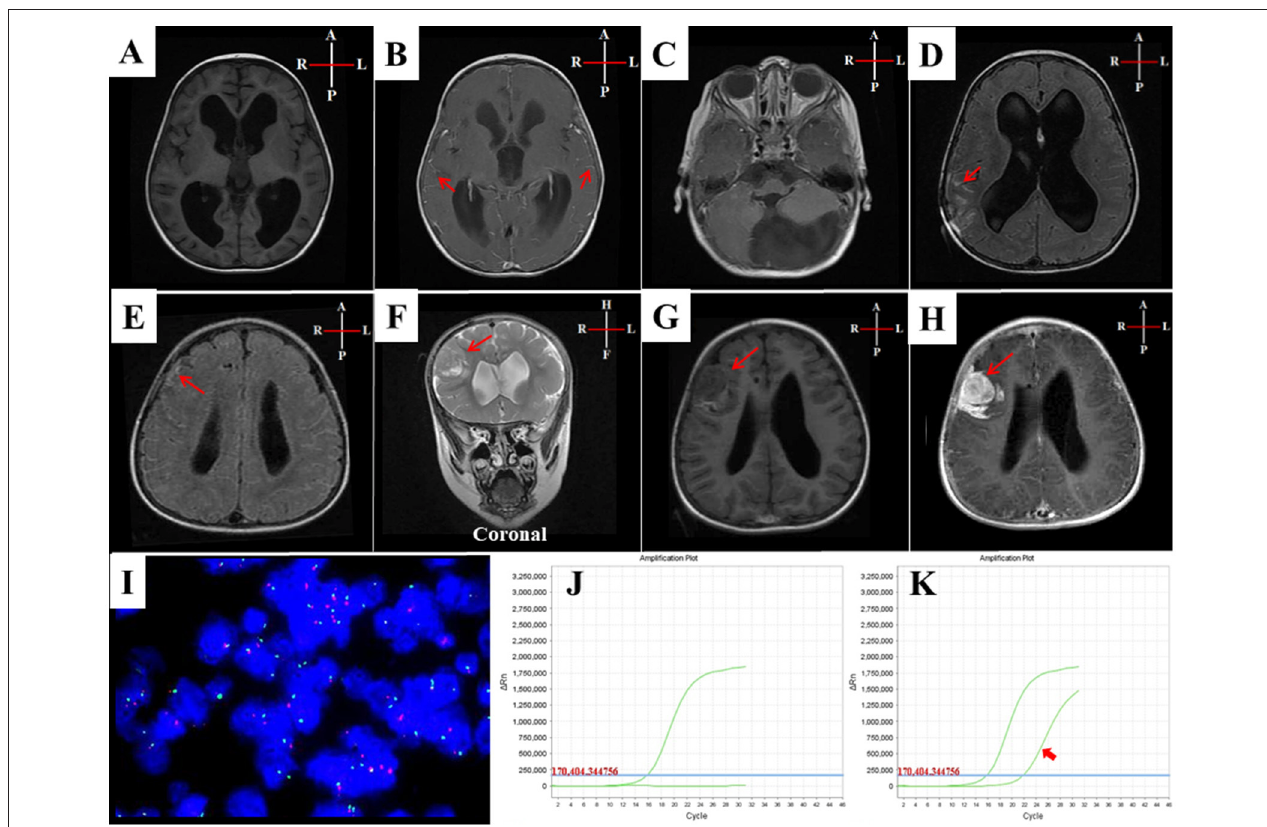
FIGURE 2 | MRI and cytogenetic characteristics of case-I. (A–H) MRI of case-I: (A) T1W-axial-pre-contrast and (B) T1W-axial post-contrast, showed hydrocephalus of third and lateral ventricles with diffuse leptomeningeal enhancements (arrows in B) . (C) T1W-axial-post-contrast at posterior fossa level, showed a normal fourth ventricle with large arachnoid cyst at cisterna magna. (D) T1W-axial-post-contrast, 3 months and (E) 6 months later, showed evidence of ventriculoperitoneal shunt with persistence of the hydrocephalus and leptomeningeal enhancement and looked thick at the right parietal lobe in D and right frontal lobe in E (arrowed). (F) T2W-coronal image (G) T1W-axial image after 9 months, showed 3cm extra-axial dural based intermediate signal lesion at the right frontal lobe surrounded by vasogenic edema causing mass effect on the right lateral ventricle and showed an intense enhancement in (H) T1W-axial-post-contrast image. (I) FISH